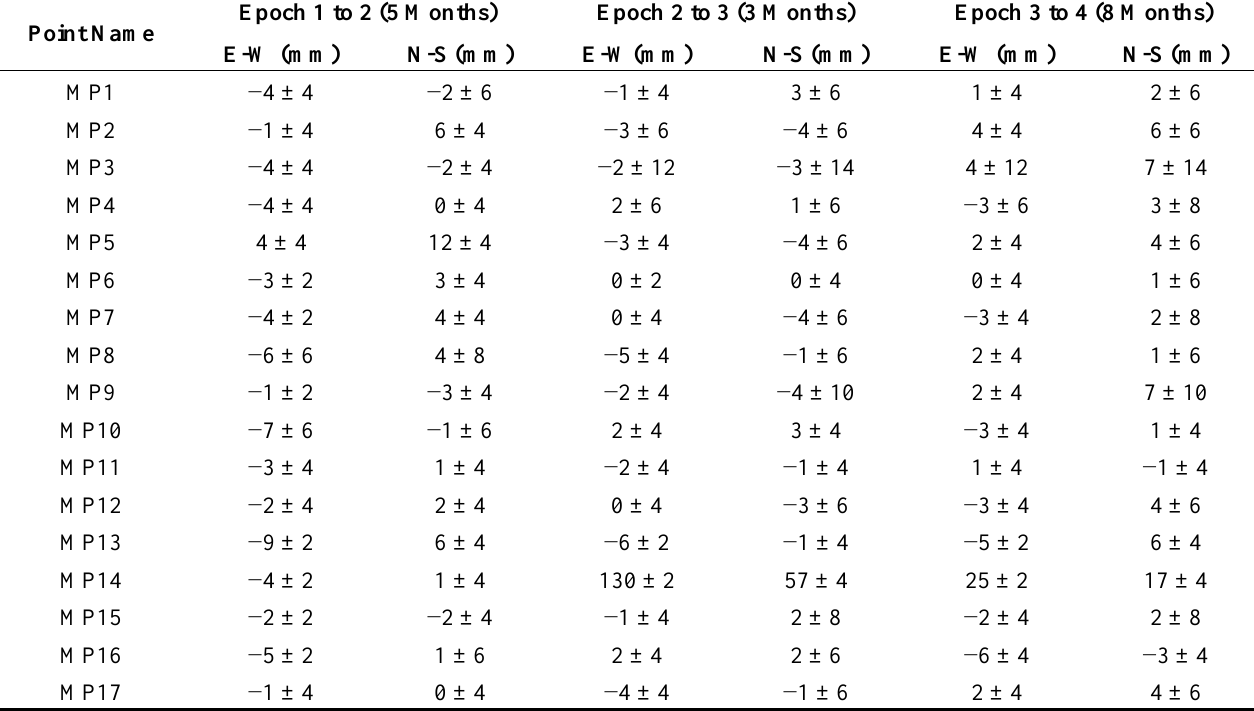
Table 4. GPS horizontal displacement for monitoring stations with 95% confidence interval.